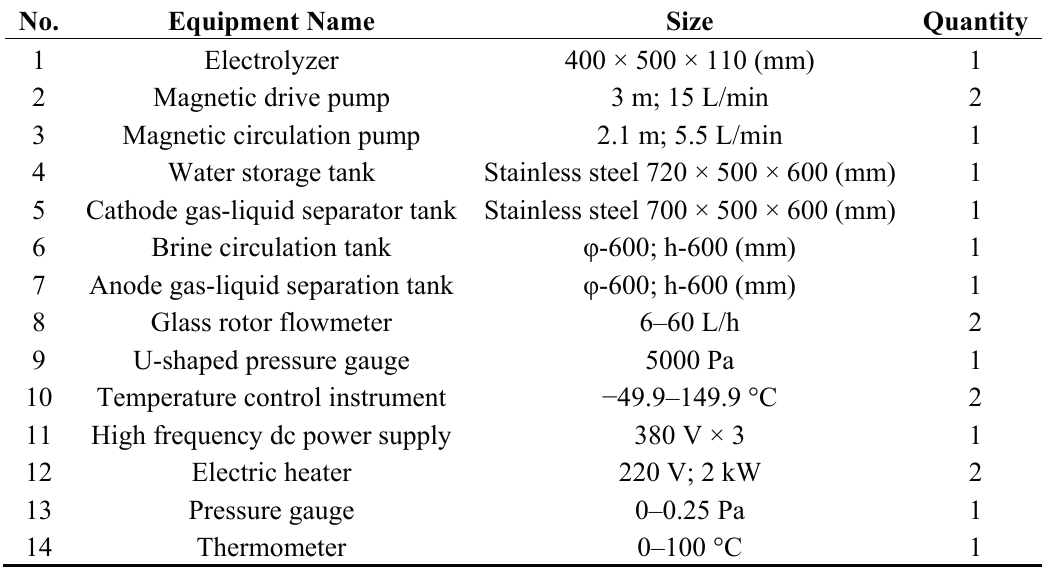
Figure 6. Schematic diagram of the ballast water treatment system. E1—electrolyzer; TK1—low concentration lye tank; TK2—high concentration lye tank; TK3—seawater tank; TK4—gas-liquid separator tank; TK5—Erlenmeyer flask; P1 P2—seawater pump; A–I—stop valve, a,c—inlet, b,d—outlet. Table 2. The main components of the treatment